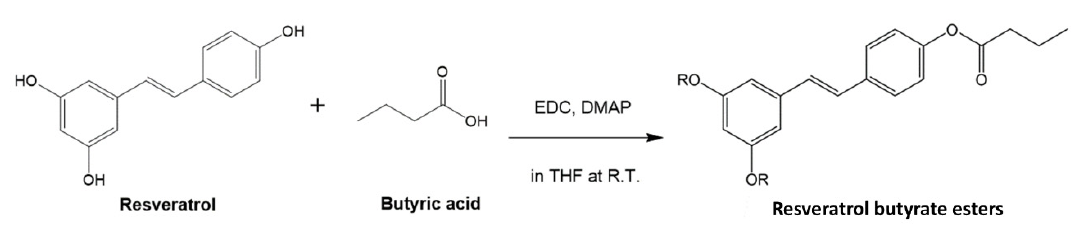
Figure 1. Synthesis of resveratrol butyrate esters. EDC, (1-ethyl-3-(3-dimethylaminopropyl) carbodiimide; DMAP, 4-N, N -dimethyl amino pyridine; THF, tetrahydrofuran; R.T., room temperature.